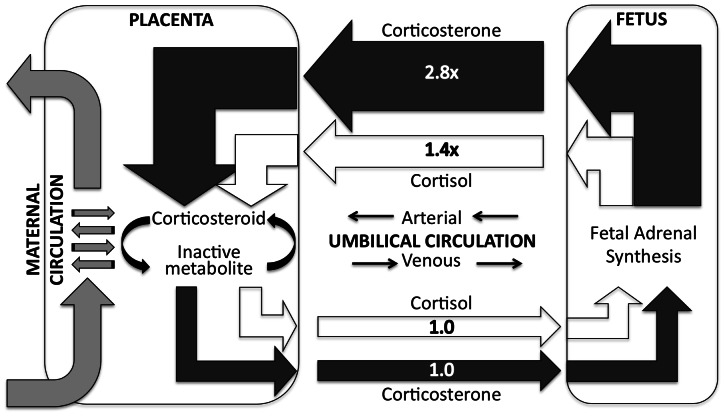
Schematic illustration of changes in median corticosteroid concentrations.Relative concentrations of corticosterone and cortisol in umbilical artery and vein, showing preferential fetal synthesis of corticosterone coupled to placental inactivation of corticosteroids.